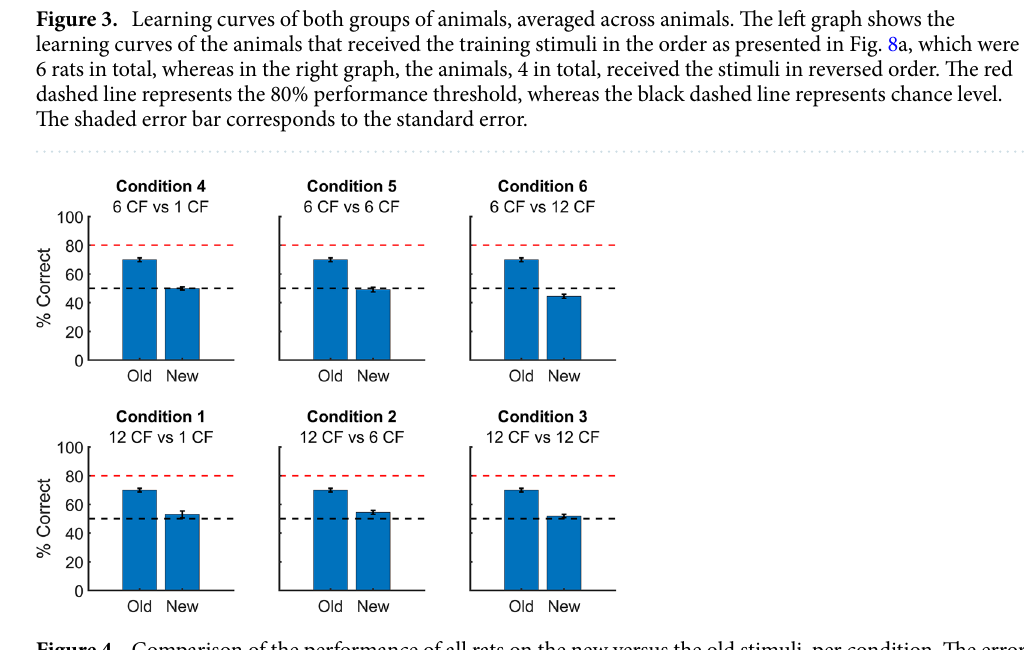
Figure 4. Comparison of the performance of all rats on the new versus the old stimuli, per condition. The error bars indicate the standard error across rats. The red dashed line represents the 80% performance threshold and the black dashed line indicates chance level. The Condition titles refer to the conditions as described in Table